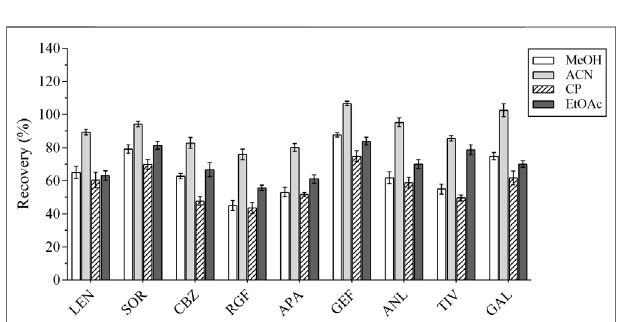
FIGURE 5 | The recovery results of all analytes with 5 adsorbents.